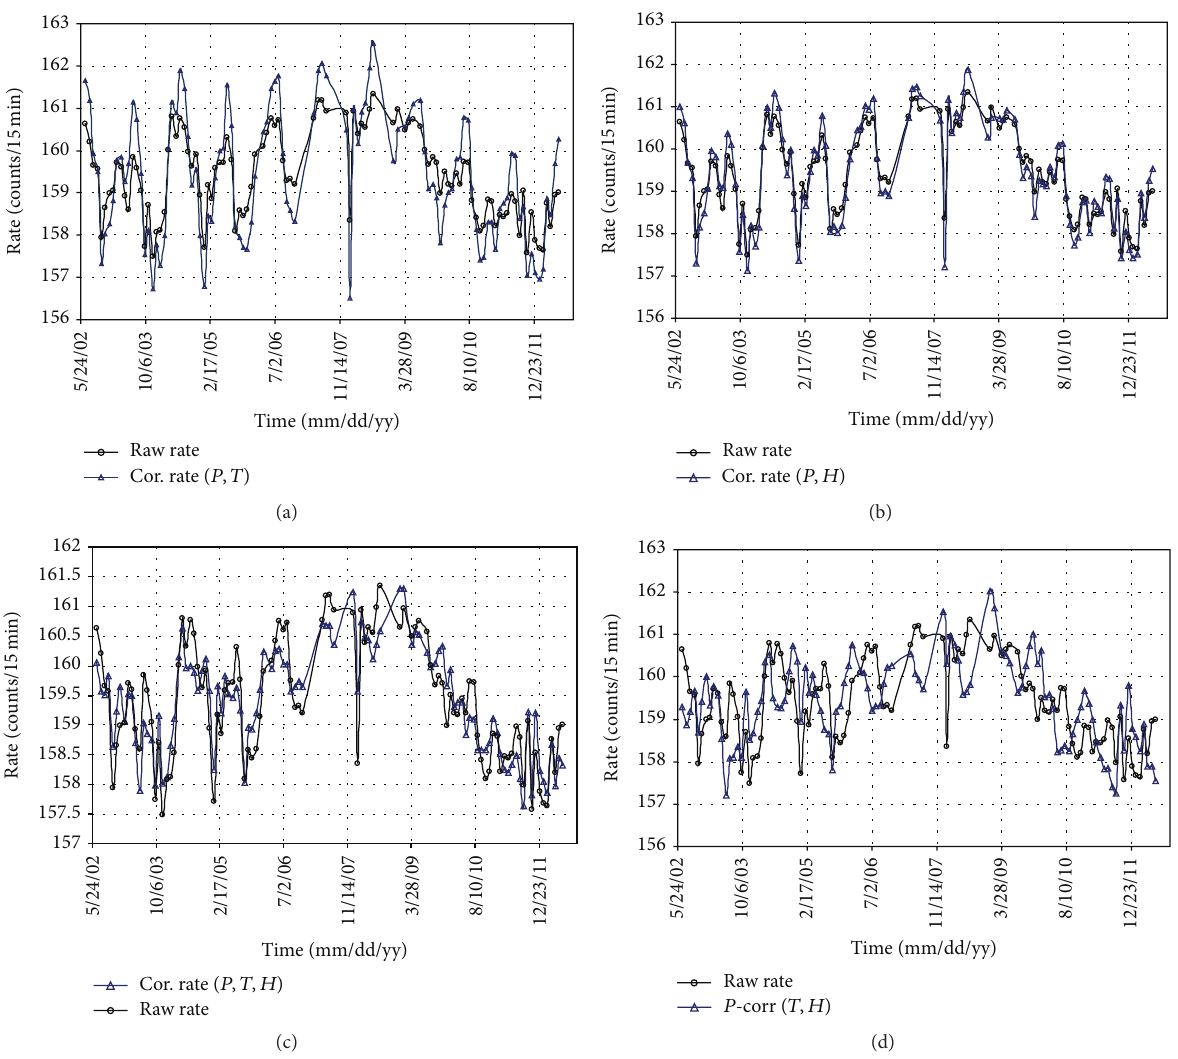
Figure 6: Example comparing the monthly values of the uncorrected muon rate for the considered period against those corrected for (a) pressure and temperature, (b) pressure and height, (c) the three parameters, and (d) pressure-corrected muons correlated with both temperature and